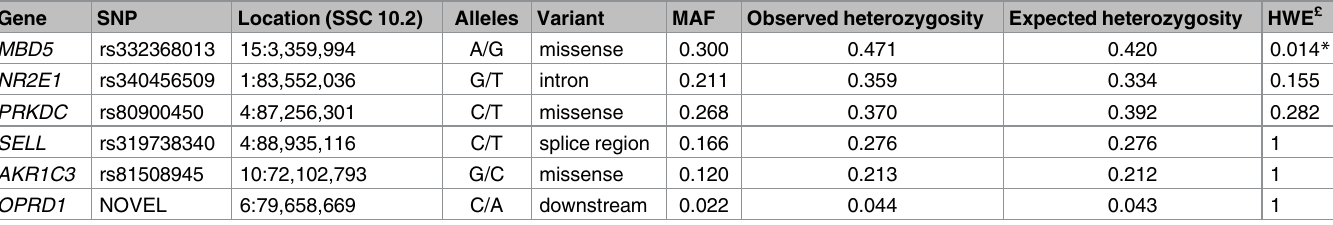
Table 5. Observed and expected heterozygosity of the SNPs selectedfor validation. Gene